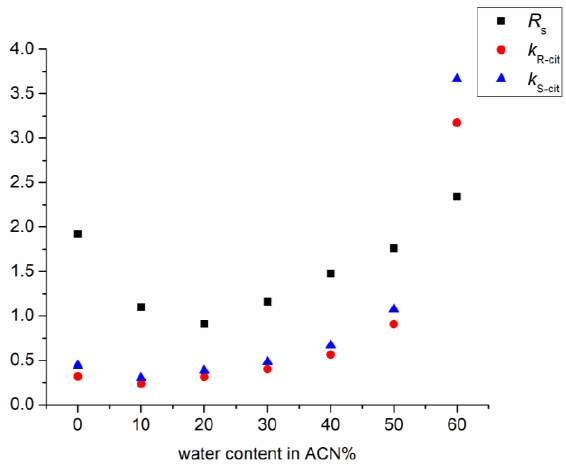
Figure 3. Plots of the retention and resolution factors as a function of the water content in acetonitrile on Lux Cellulose-1 column. (Chromatographic conditions: mobile phase 0.1% DEA in the indicated eluent composition, flow rate: 0.6 mL/min; column temperature: 25 °C).